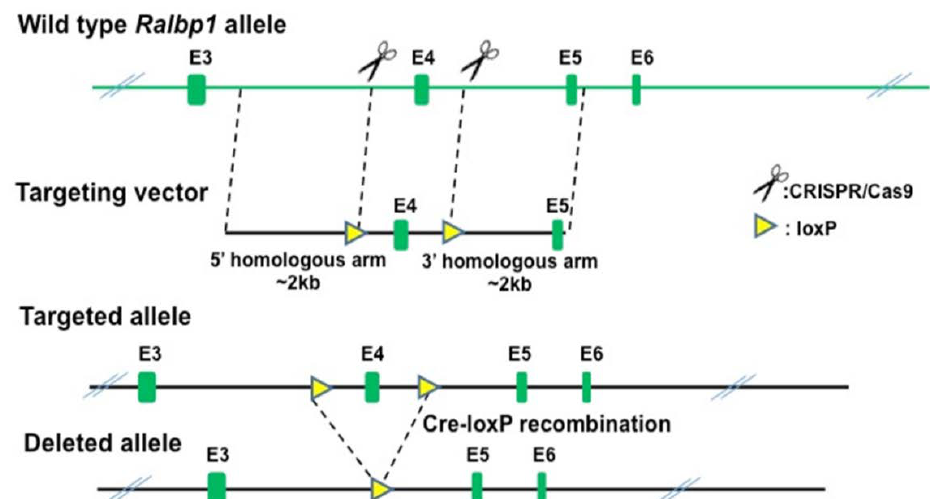
Figure 1. Schematic representation of the wild type and mutant/targeted alleles. This design uses the Cre-loxP system to delete exon 4 of RALBP1 . The introns occurring between exons 3 and 4 and between exons 4 and 5 are large and insertion of the loxP element will not interfere with mRNA splicing. To minimize the possibility of disruption of EGE-LBX-020 expression, both of the loxP sites were inserted into non-conserved regions. Exon 4 knockout was validated by Southern blot and PCR.